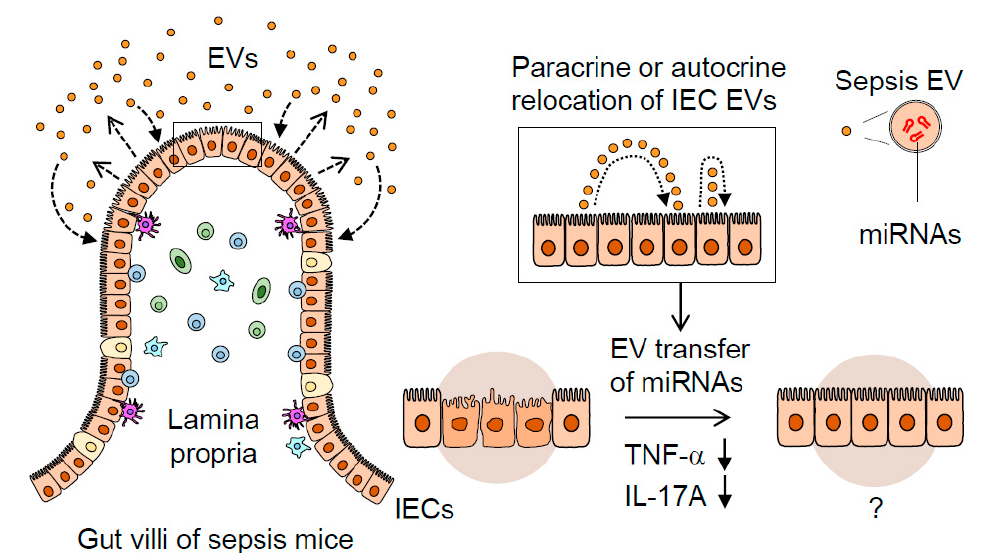
Figure 5. A proposed mechanism illustrating the dynamic role of septic IEC-derived luminal EVs in regulating gut inflammation. Sepsis induces gut-barrier dysfunction and epithelial injury. Sepsis-induced luminal release of EVs increases their epithelial trait. The luminal EVs possessing different miRNA expression levels relocate themselves to IECs in either a paracrine or autocrine fashion. Thus, the EVs secreted from IECs are thought to contribute to dampening pro-inflammatory responses in sepsis-damaged gut mucosa via the transfer of regulatory miRNAs.